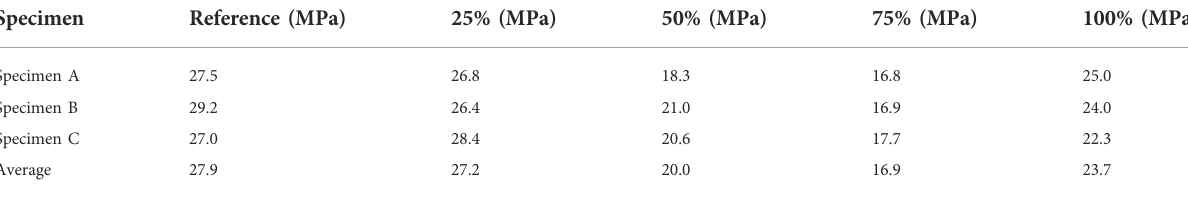
TABLE 4 Compressive strength test results for concrete